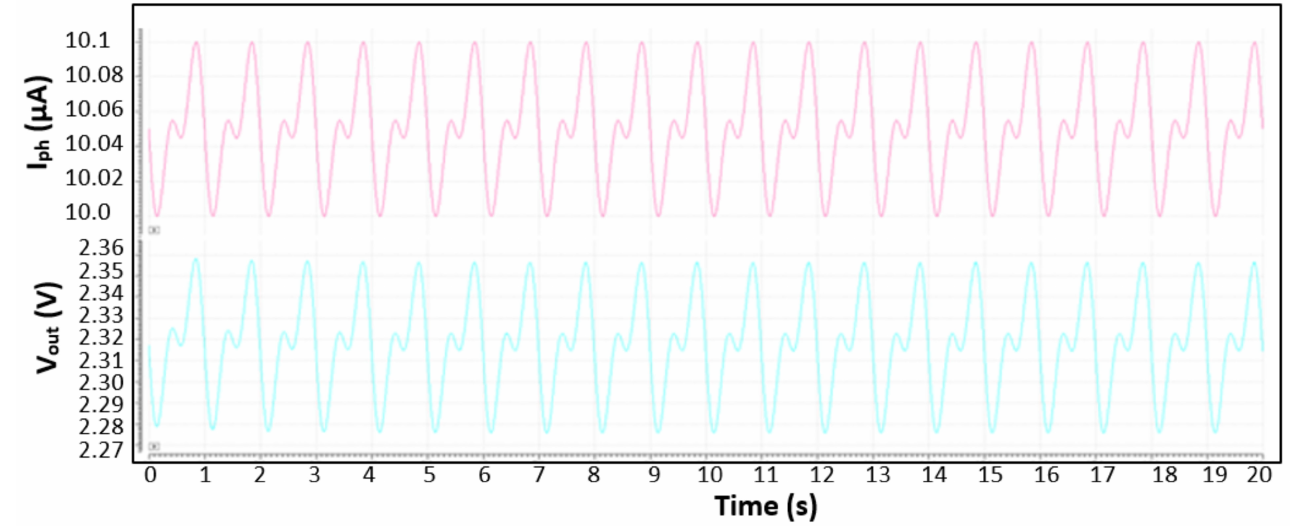
Figure 3. The input PPG photocurrent (10 µ A) and the output